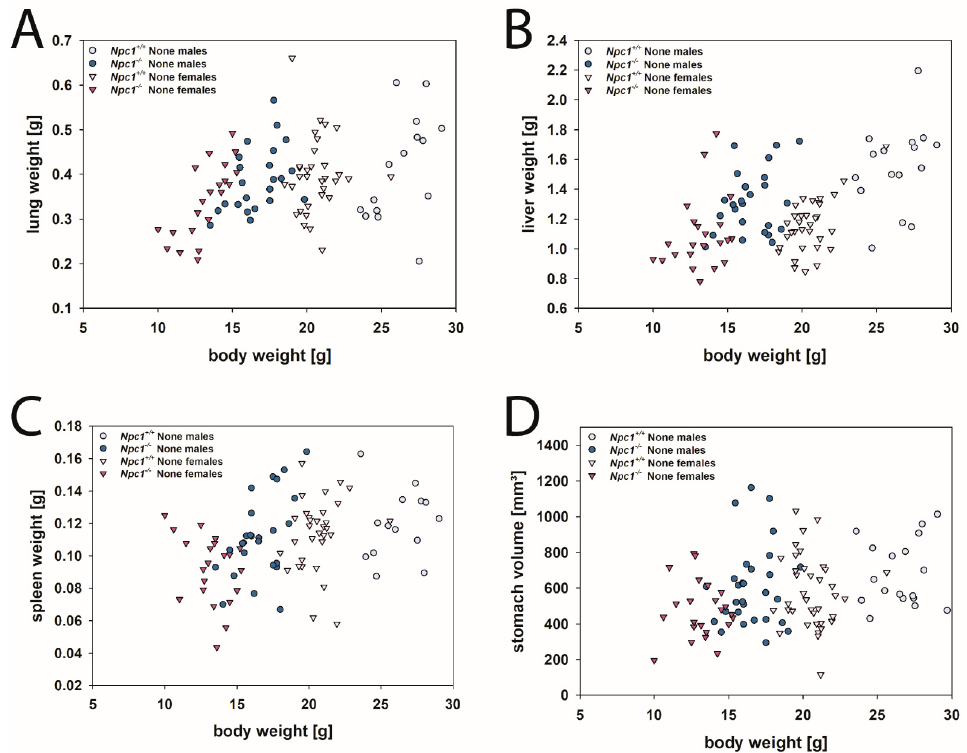
Figure 16. Organ weight in relation to body weight of individual Npc1 − / − and Npc1 +/+ mice of the None groups: ( A ) lung, ( B ) liver, ( C ) spleen, and ( D ) volume of the stomach. Systematic studies dealing with gender-specific organ weights of Npc1 +/+ and Npc1 − / − mice are rare. To our knowledge, only Xie et al. [102] studied both genders separately, stating that in both Npc1 +/+ and Npc1 − / − mice, females had lower liver weights than males. The absolute liver weight was 1.32 ± 0.04 g in male Npc1 +/+ mice and 1.11 ± 0.03 g in female Npc1 +/+ mice. The respective body weights were 23.1 ± 0.3 g in male Npc1 +/+ mice and 19.6 ± 0.2 g in female Npc1 +/+ mice. These data correspond well with our results in female and 1.549 ± 0.070 g and in female Npc1 +/+ mice, 1.160 ± 0.038 g. The respective body